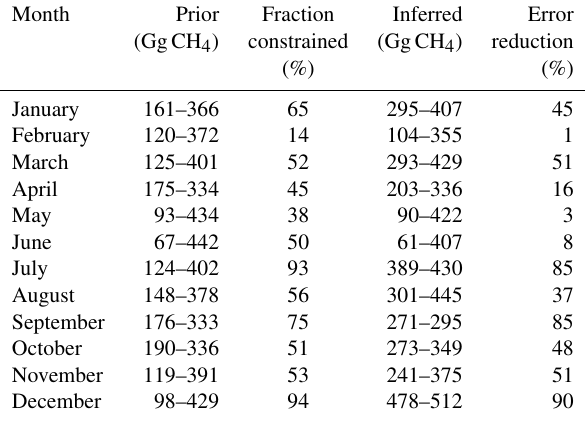
Table 3. Regional run: French monthly total CH 4 emissions (in GgCH 4 ) in 2012: prior confidence range (provided by our method, see Sect. 2.3), fraction of prior constrained by the inversion in %, confidence range for the inferred emissions and error reduction in % (see Sect. 2.3 for definition). No. of data used: number of data used as constraints by the inversion for each month.